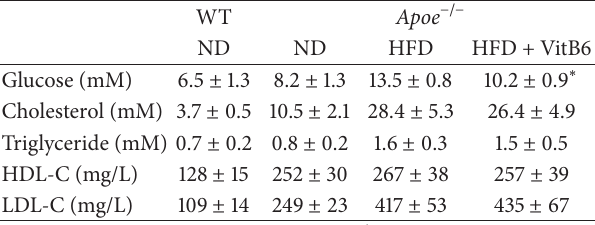
Table 1: Serum sugar and lipid levels in Apoe −/−